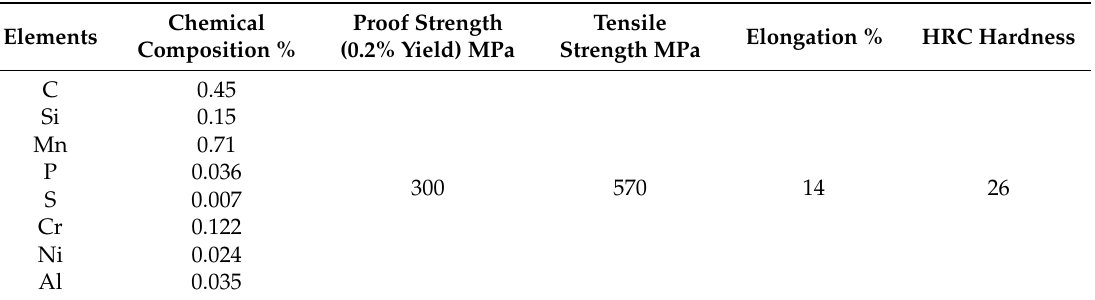
Table 1. Chemical composition of AISI